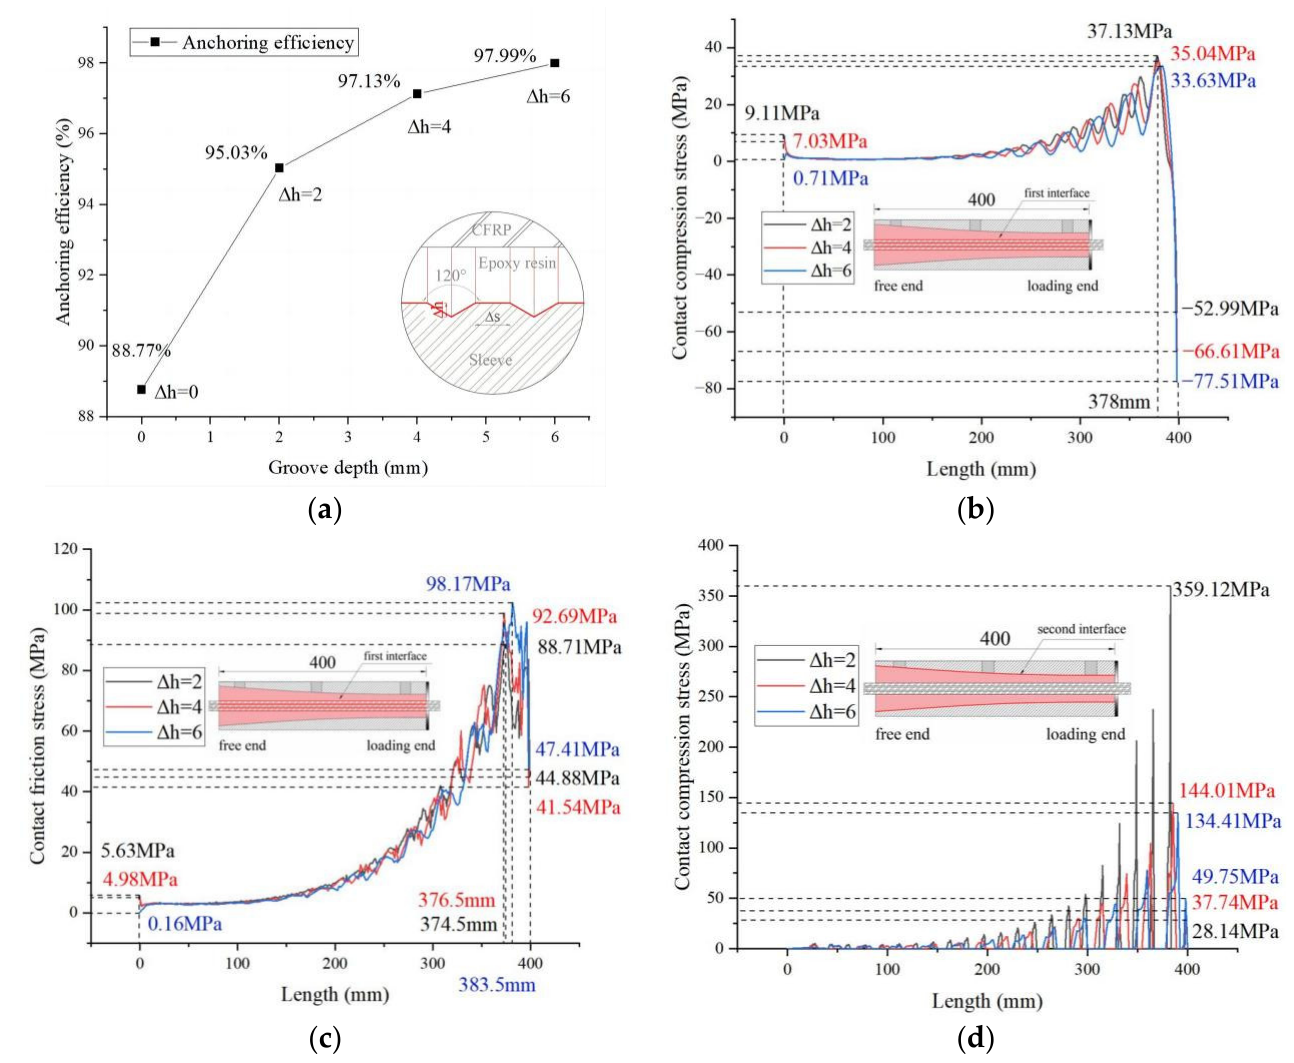
Figure 10. Effect of groove depth on mechanical properties: ( a ) tensile test—anchoring efficiency; ( b ) FE analysis—contact compression stress of the first interface (CFRP–epoxy resin); ( c ) FE analysis—contact friction stress of the first interface (CFRP–epoxy resin); ( d ) FE analysis—contact compression stress of the second interface (epoxy resin–sleeve).